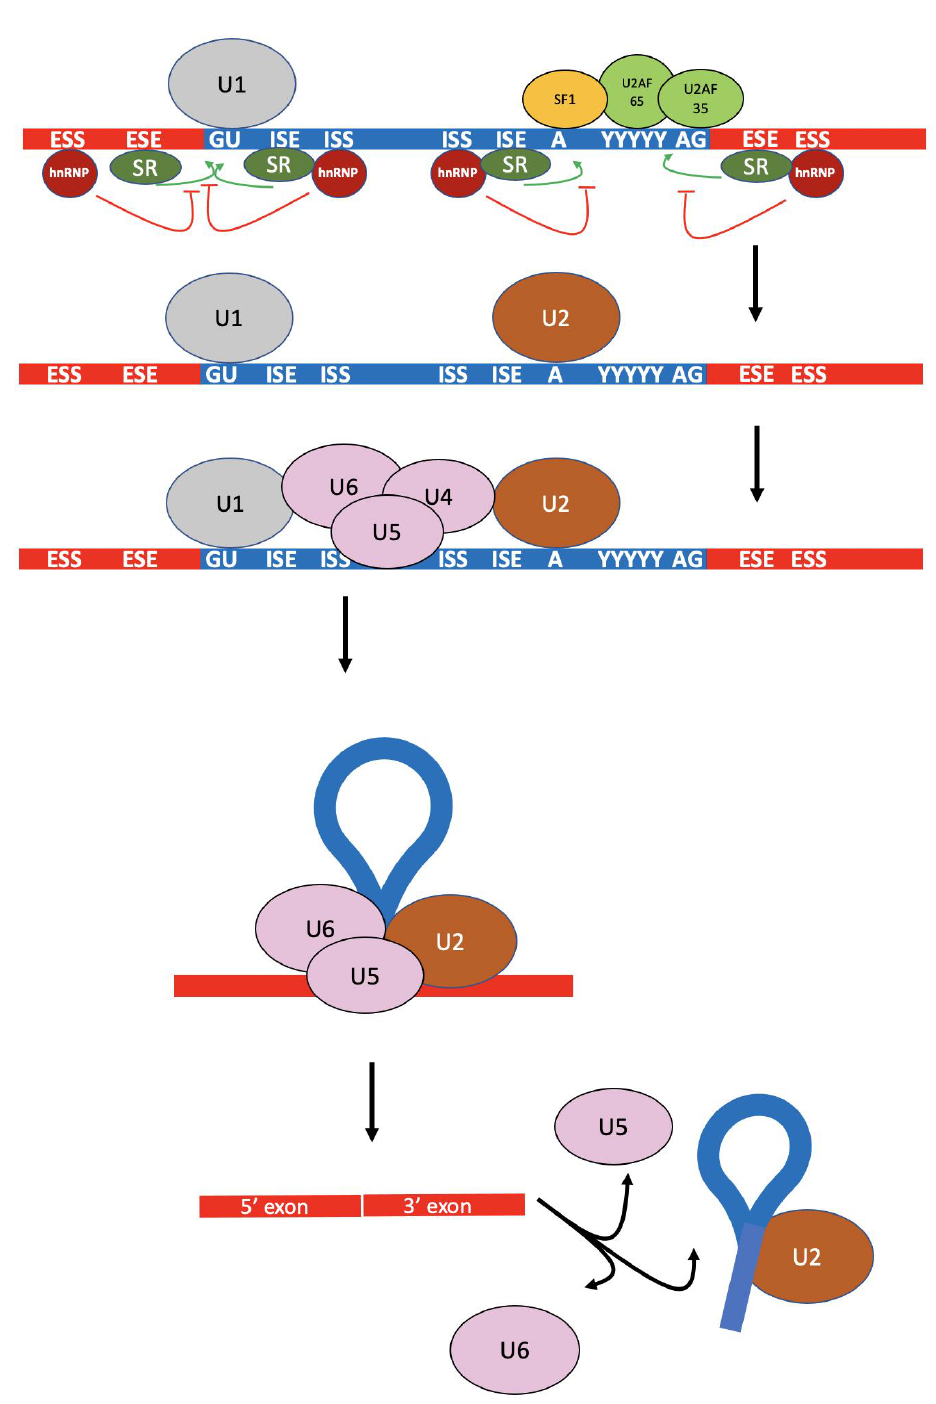
Figure 1. The multi-step mRNA splicing process shown for a single pair of exons. U2AF 35 and 65 proteins bind at the splice acceptor site and the polypyrimidine tract near the branchpoint adenine. The SF1 protein is bound at the site surrounding the branchpoint site, and the U1 snRNP is bound at the splice donor site. These activities can be promoted by SR proteins bound to splicing enhancers or inhibited by hnRNPs bound to splicing suppressors. SF1 and the auxiliary factors are supplanted by U2, followed by the binding of the U4/U5/U6 trimer. The intronic lariat is formed as a 5′ to 2′ phosphodiester bond between splice donor guanine and the branchpoint adenine as U1 and U4 leave the spliceosomal complex. The 5′ exon then joins the 3′ exon as the lariat is released.